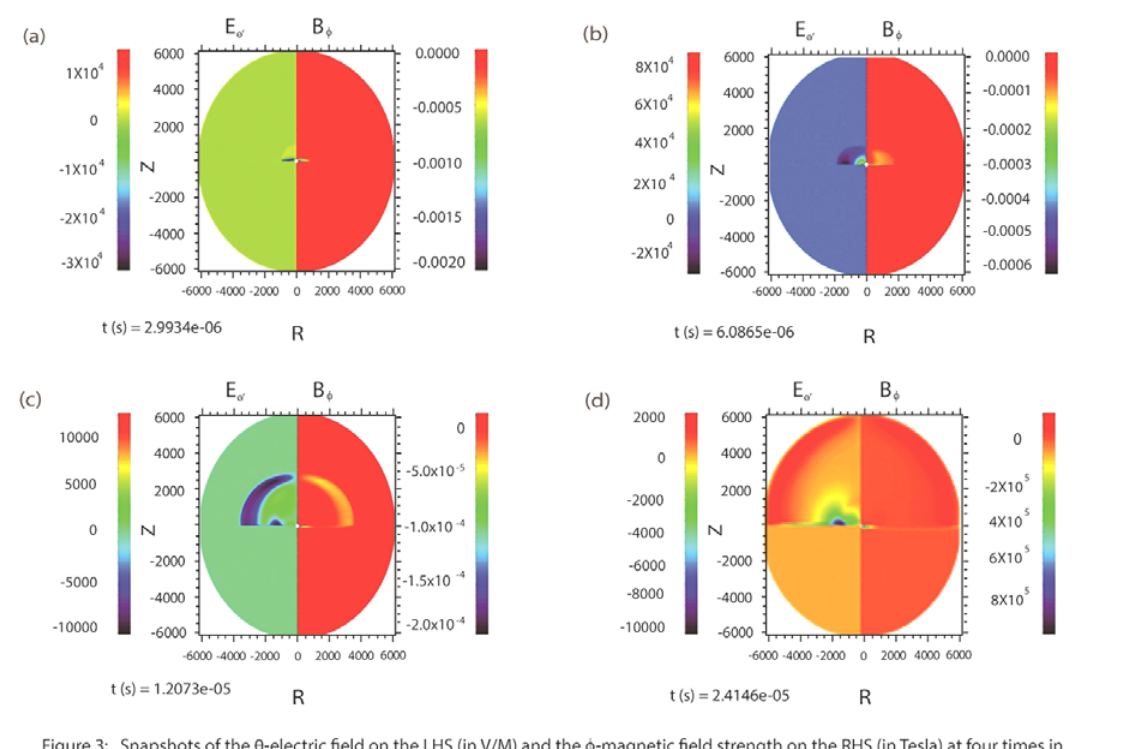
Fig. 3(c). This field drives Compton electrons into the ground. Note also that the θ -electric field develops initially near the ground and then propagates along the radial and theta directions. The fields near the ground are associated